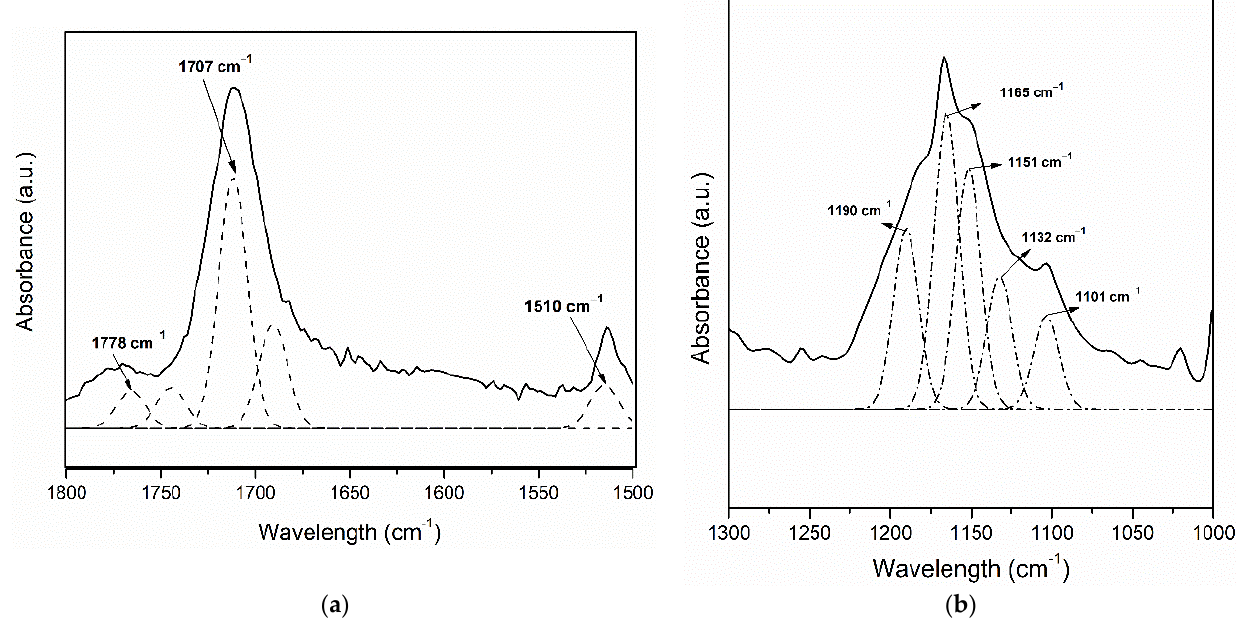
Figure 5. An example of deconvoluted spectrum of TG1A150 (ashed lines) within the wavelength of 1500 − 1800 cm −1 ( a ) and 1000 − 1300 cm −1 ( b ).